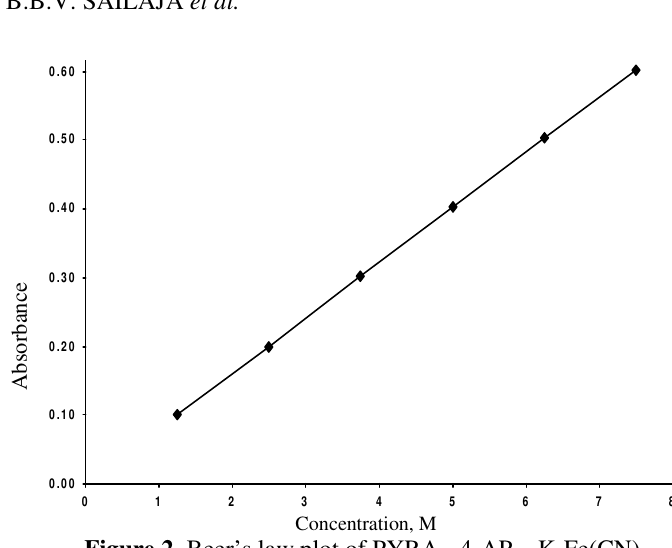
Figure 2. Beer’s law plot of PYRA - 4-AP – K